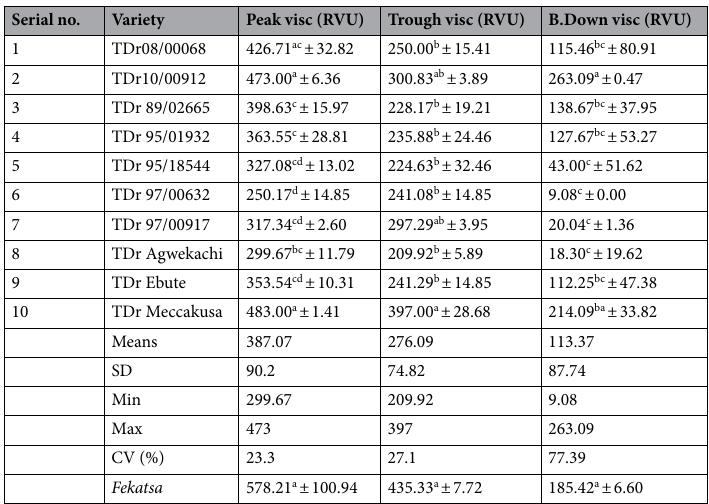
Table 2. Yam varietal effects on the pasting attributes (peak viscosity, trough viscosity, and breakdown viscosity) of the instant pounded fufu samples as obtained from control( Fekatsa ) and 10 improved varieties of Dioscorea rotundata. Parameter mean value ± SD; Values with the same superscripts in the same column are not significantly different ( p > 0.05); Visc Viscosity, B. Down breakdown, RVU Rapid Visco Analyser